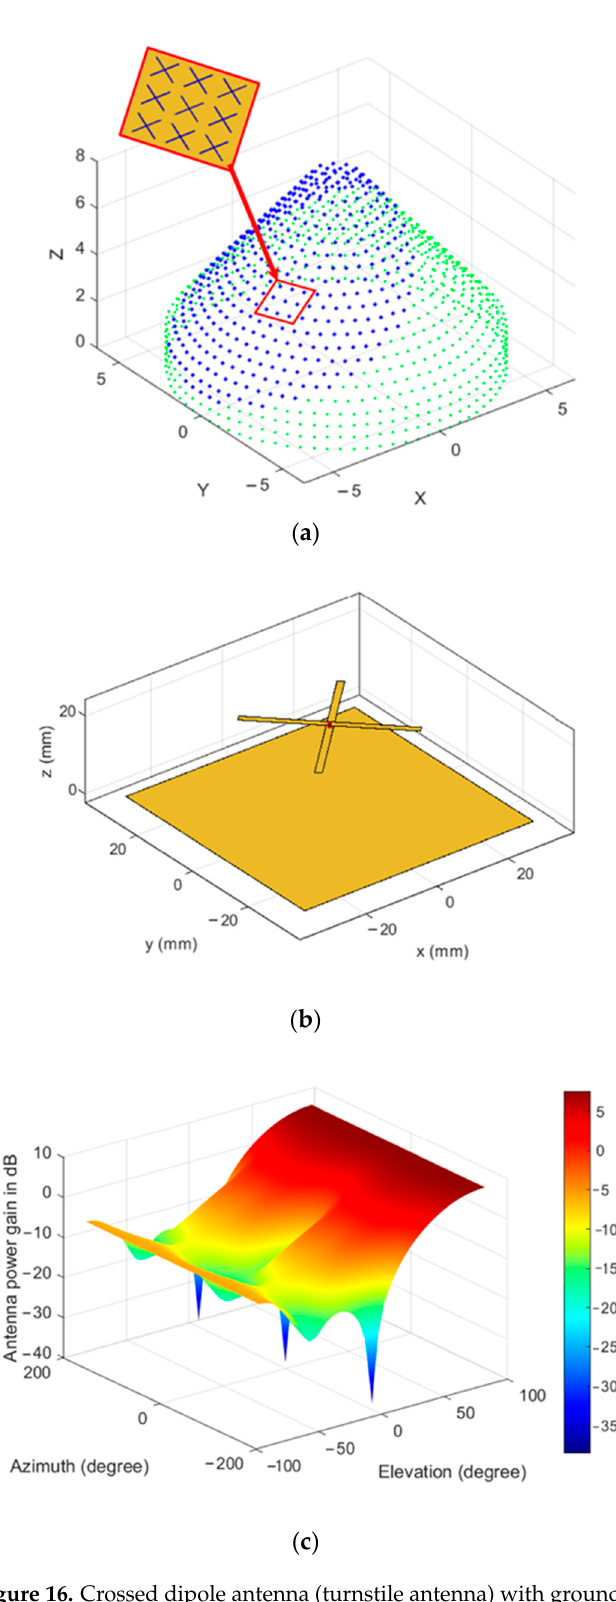
Figure 16. Crossed dipole antenna (turnstile antenna) with ground metallic plane: ( a ) complete CSC 4 array with active elements in blue colored dots and distances normalized to wavelength, ( b ) single crossed dipole element structure at frequency of 3.5 GHz, and ( c ) is the single antenna element radiation pattern.